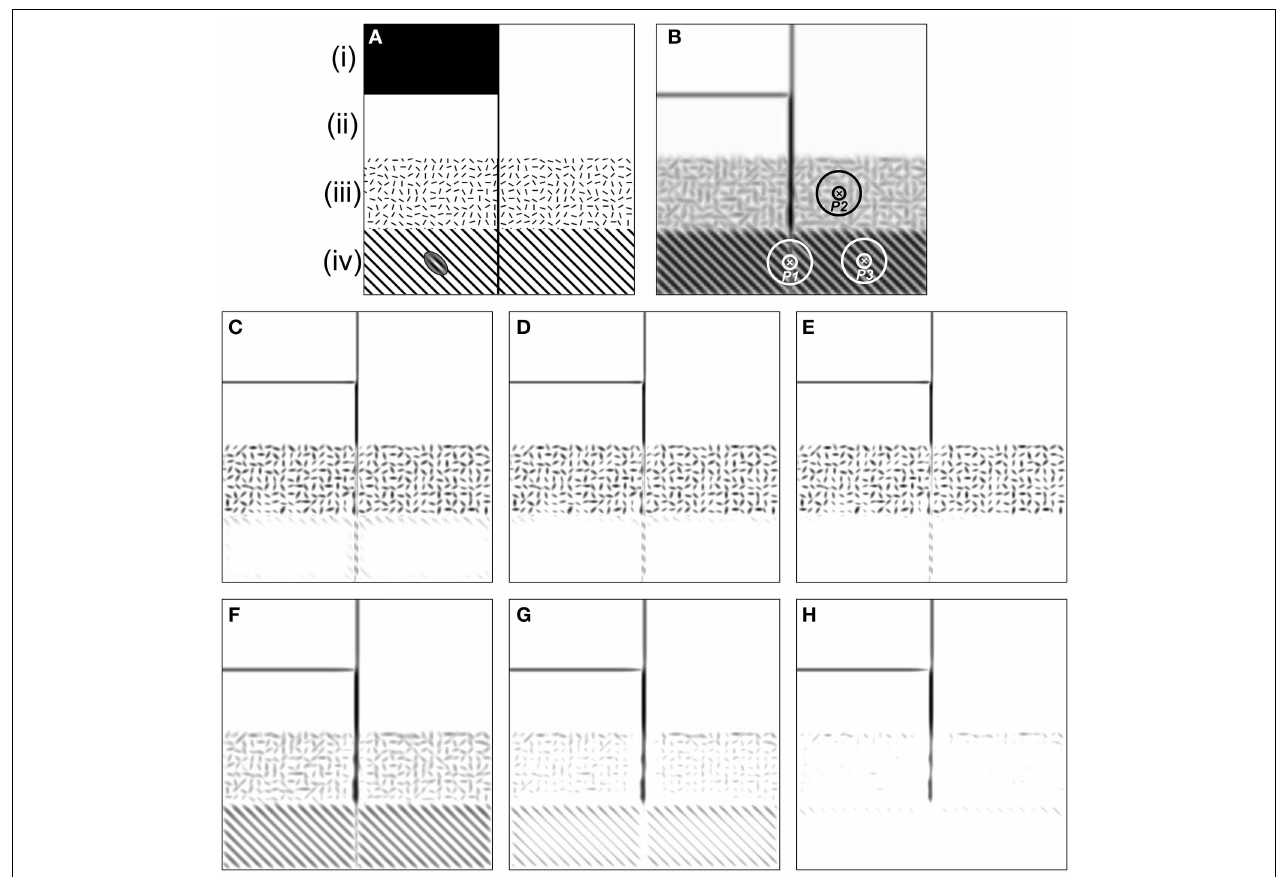
FIGURE 2 | Results of the orientation-selective inhibition operator and non-selective inhibition operator on the synthetic map. (A) There are four kinds of backgrounds [i.e., (i)–(iv)] included in the image. The inset of the ellipse-shaped Gabor filter on region (iv) illustrates the preferred frequency of CRF compared to that of the grating element. (B) The maximum Gabor energy map. The concentric circles denoting the DOG-shaped RF (CRF plus nCRF) illustrates the relative size of the RF compared to the stimulus element. Point P1 is on the salient line segment embedded in the grating texture, P2 locates in the cluttered texture, and P3 is in the grating texture. Note that darker pixels correspond to higher neuronal responses, which holds for (C – H) . (C – E) are the final responses of the orientation-selective inhibition operator with three different inhibition strengths: α = 1.6, 1.8, and 2.0, respectively